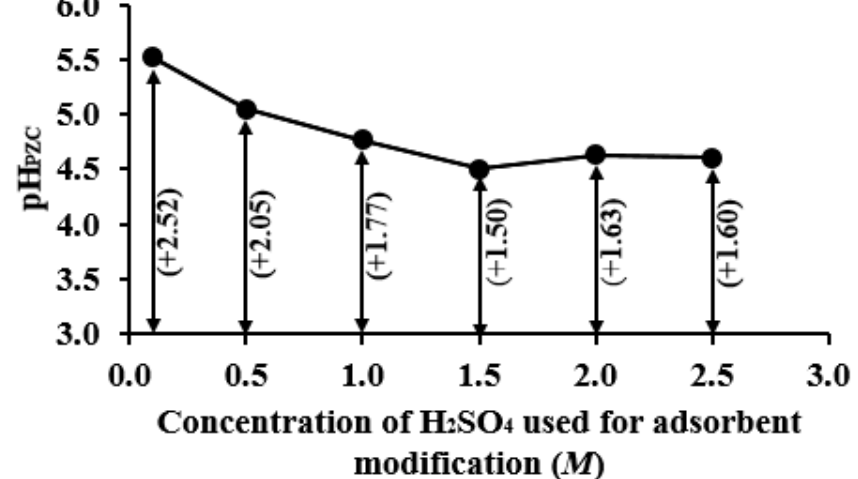
Figure 2. The point of zero charge (pH PZC ) values of various acid-modified sugarcane-bagasse-based adsorbents. The values in parentheses indicate the positivity of pH PZC subtracted by pH 3, i.e., the pH of the adsorption medium.